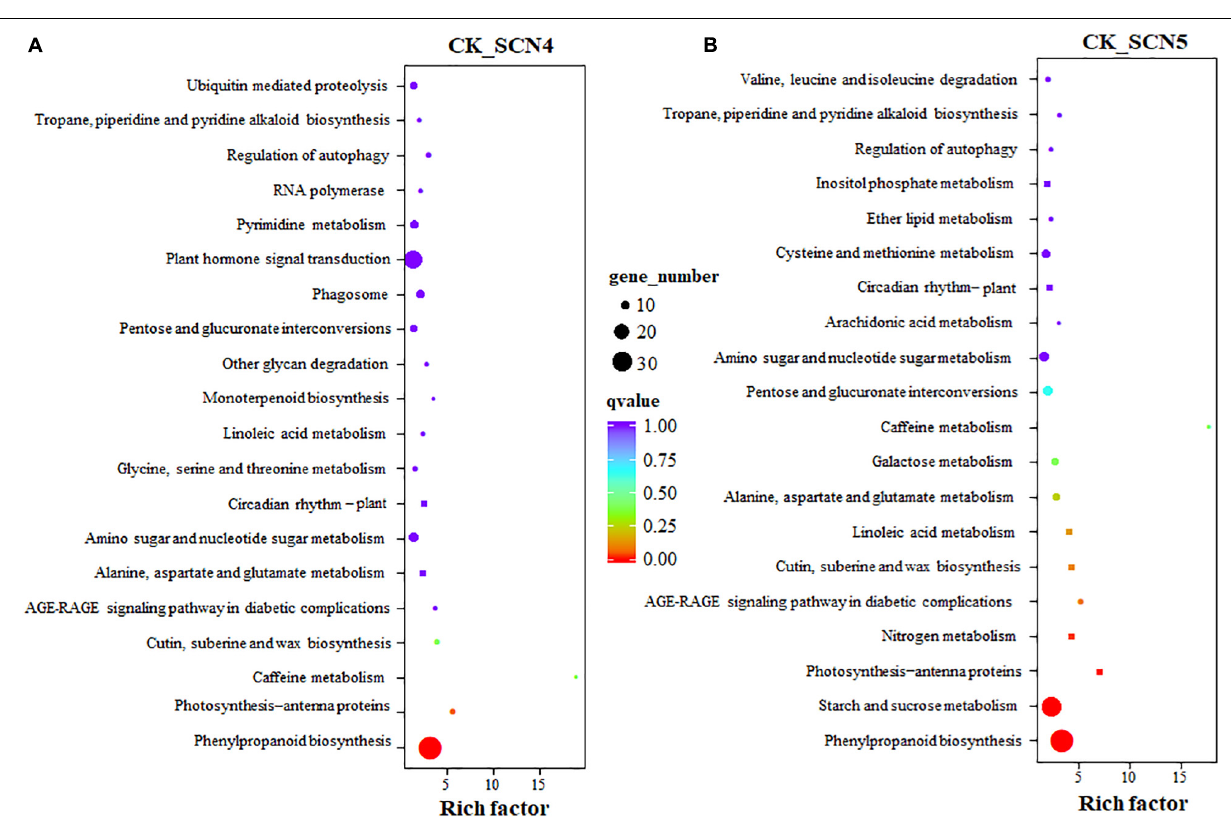
Frontiers in Plant Science |